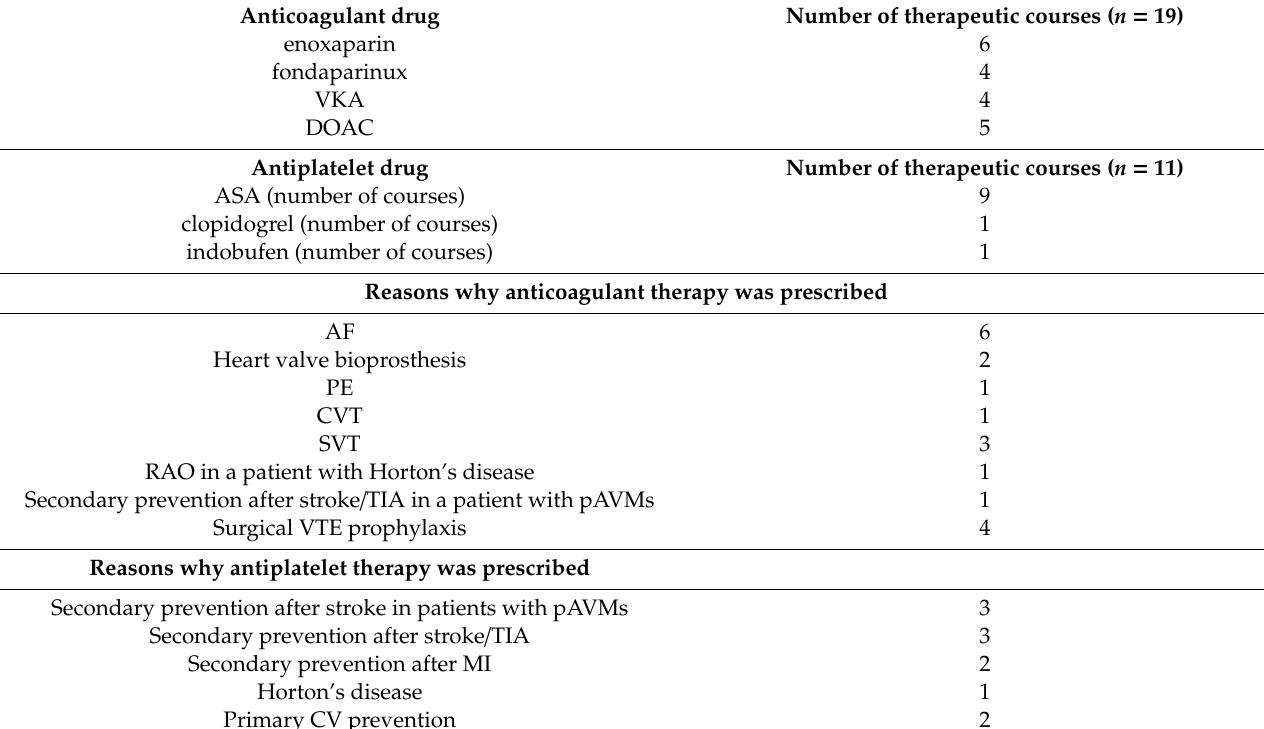
Table 2. Type and number of AT courses and reasons for